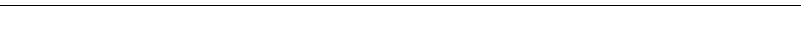
Figure 3: Identifying Zip Codes Within the Cluster Area. (A) Clusters identified using the Food Access Research Atlas; (B) Zip code map of area the cluster is located in retrieved from www.unitedstateszipcodes.com; (C) Visual overlay of maps A and B showing the food desert cluster includes two zip